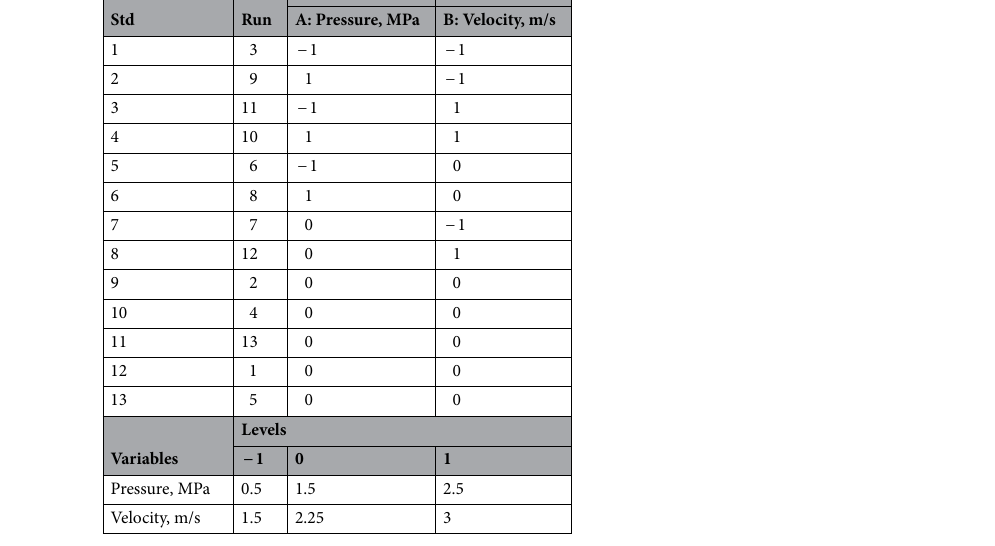
Table 1. Experimental central composite design (CCD).